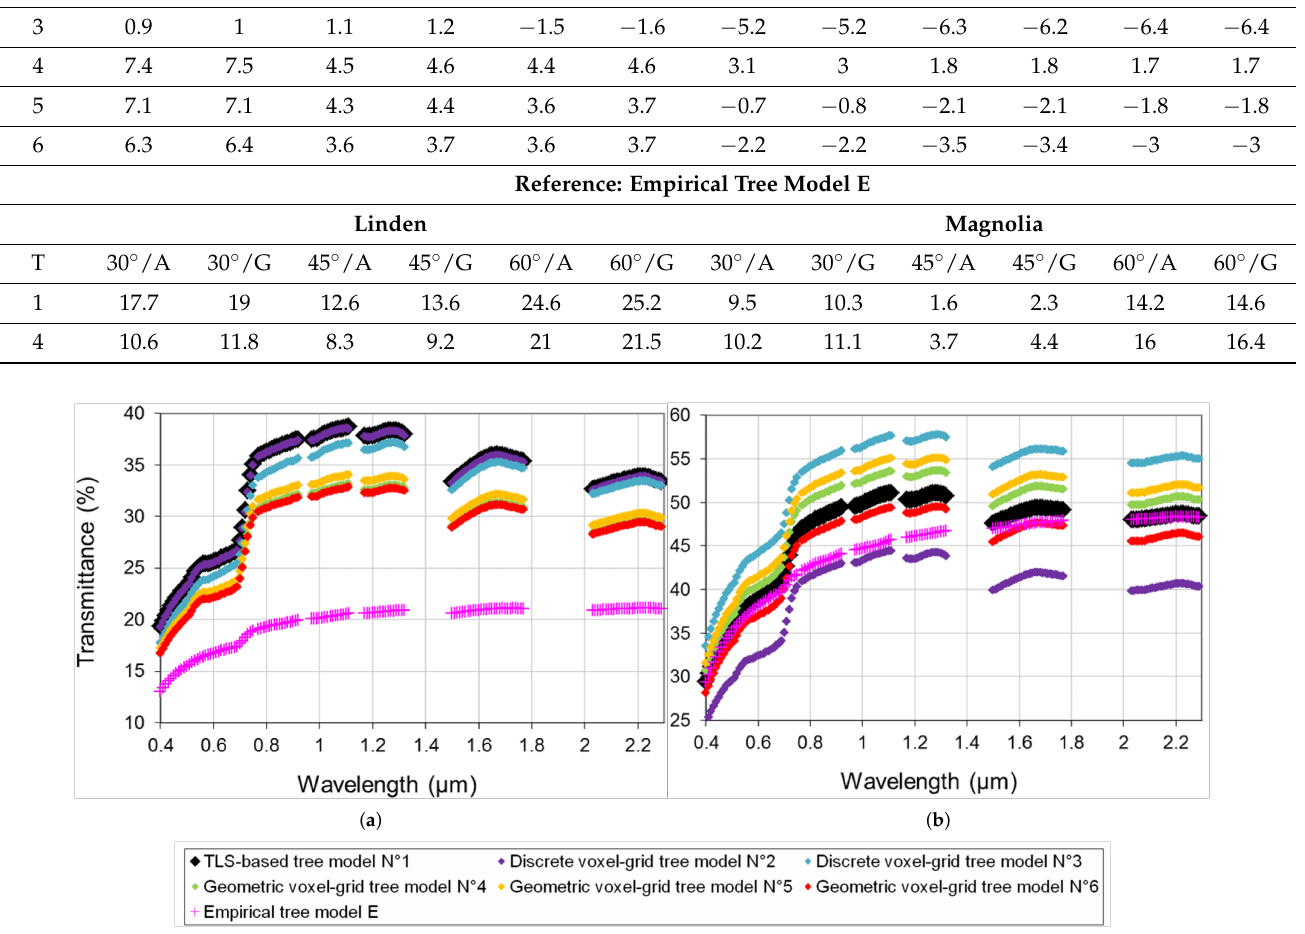
Figure 8. Comparison of the simulated mean tree crown transmittances for the tree models from n ◦ 1 to 6 and the predicted Figure 2. This is a wide figure. one from the empirical tree model, for ( a ) the linden and ( b ) the magnolia tree (SZA = 45 ◦ and BACKGROUND =